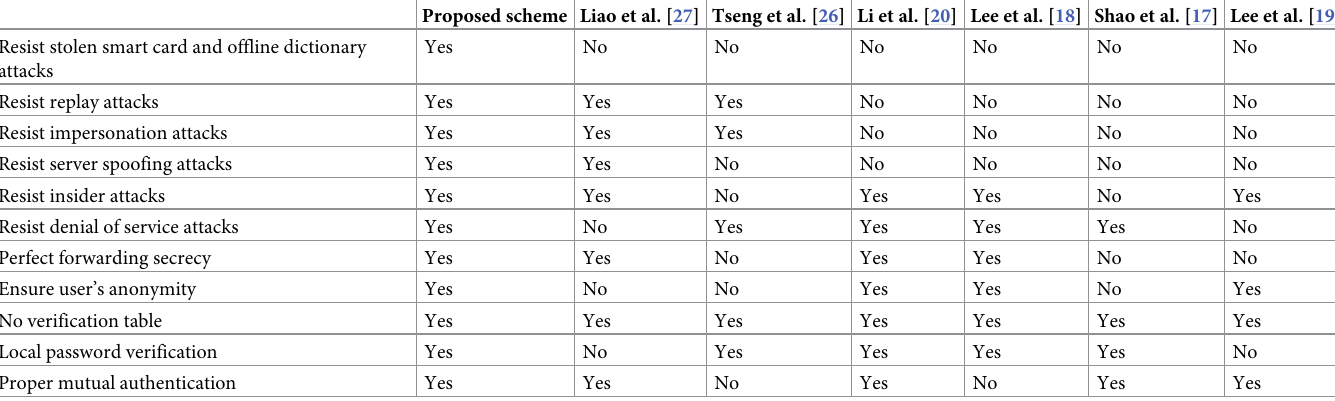
Table 3. Functionality comparisons among related multi-server authentication